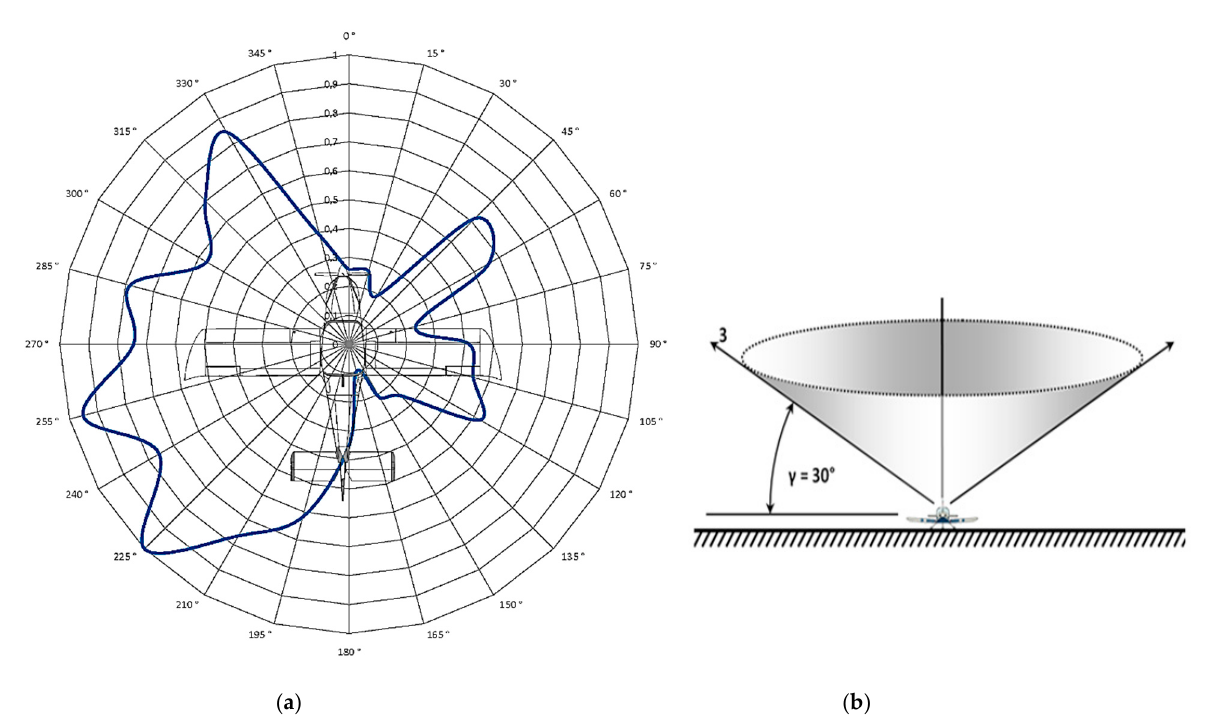
Figure 12. Measurement of the aircraft antenna characteristic at a position angle θ of 15°: ( a ) polar characteristics of the antenna; ( b ) spatial illustration of the measurement.